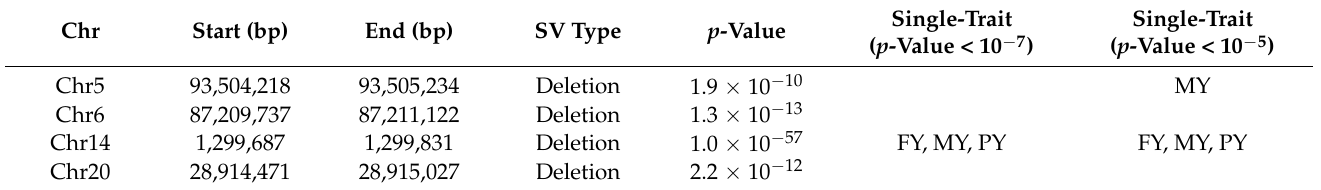
Table 2. Significant SVs in the production multi-trait meta-analysis GWAS with p -value < 10 − 7 .